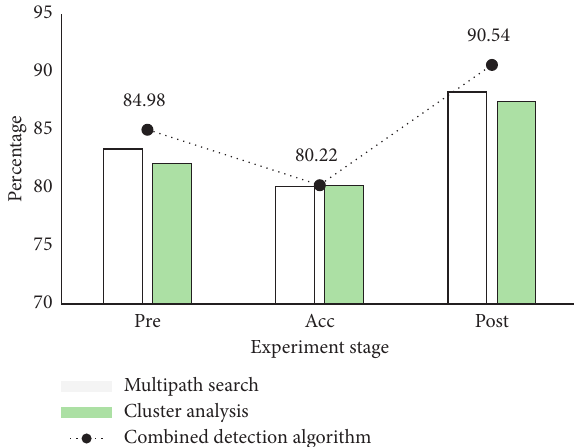
Figure 7: The result under the number of instruments of 3.